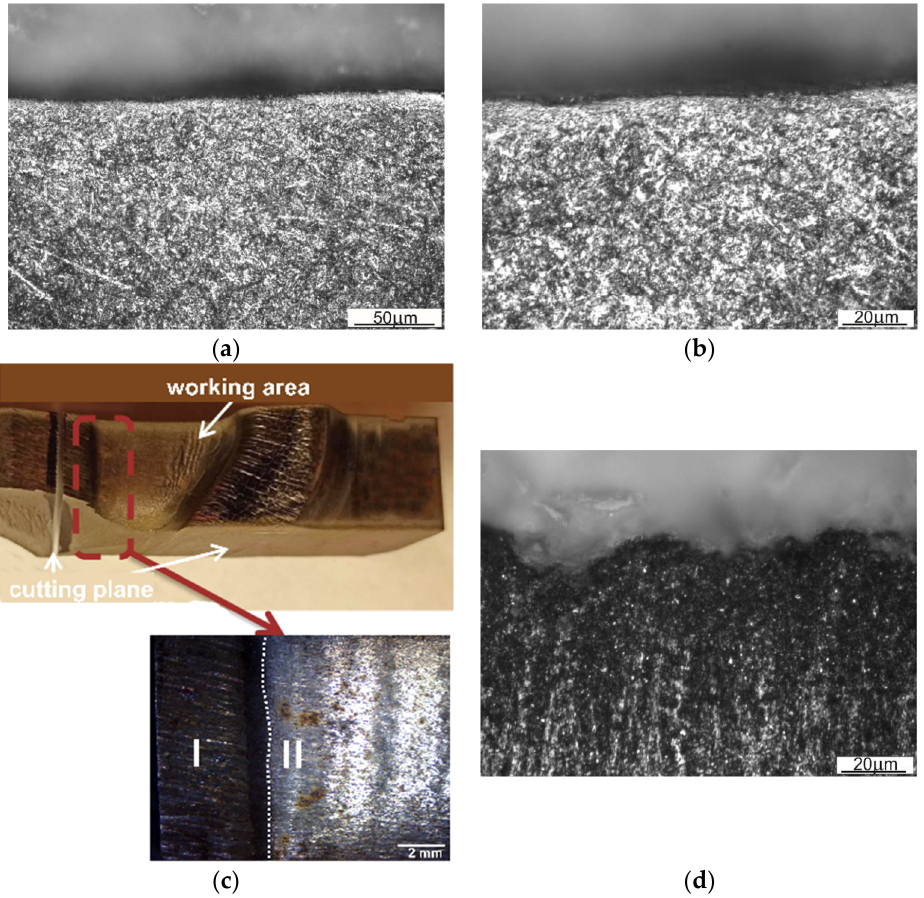
Figure 4. Microstructure of: ( a ) the top layer lying on the surface, having no contact with the wrought forging (area 1a), ( b ) the magnification of area 1a, ( c ) view of a fragment of the insert with inner web (area 2a), and ( d ) microstructure of the top layer in the area of an inner web (area 3a).